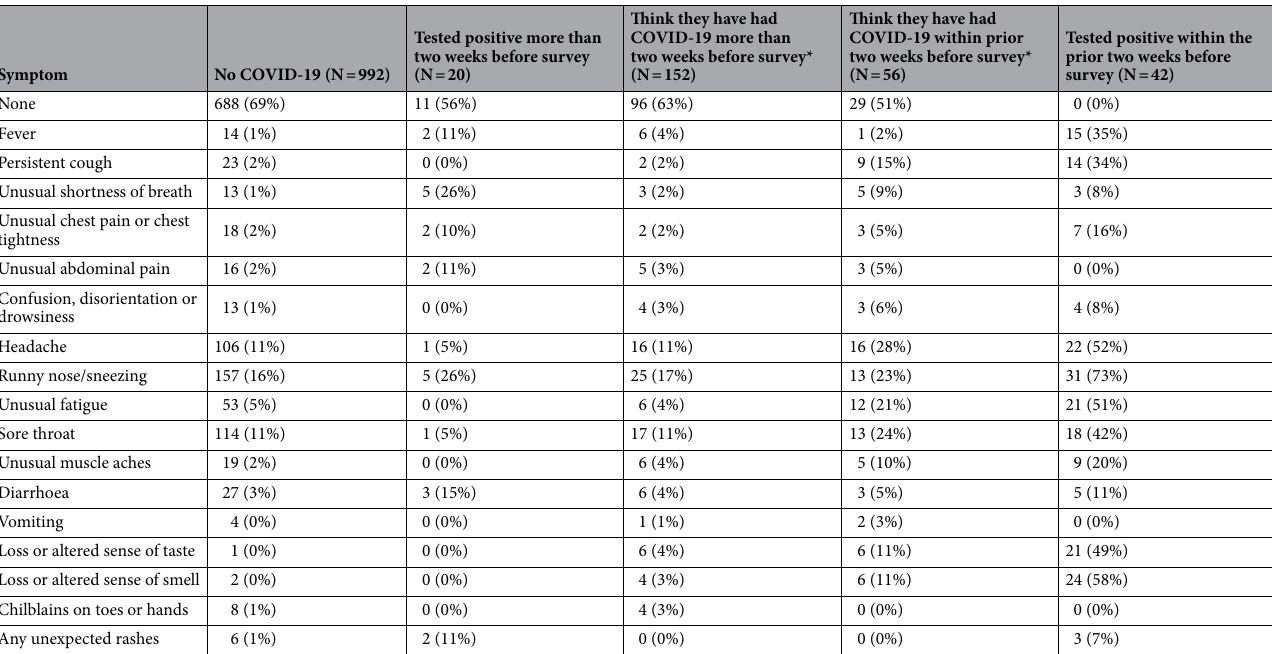
Table 3. Number and percentage of students with symptom type within the week before survey completion, stratified by COVID-19 status. *Medical professional’s opinion or personal